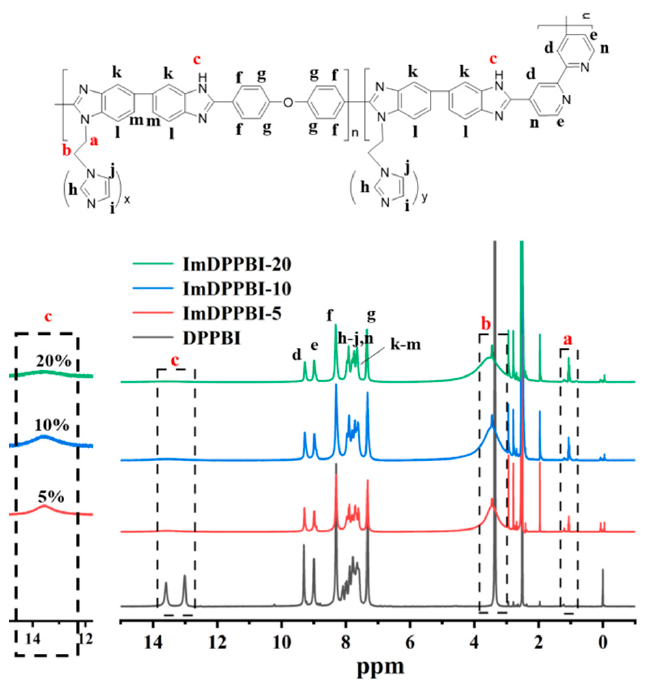
Figure 2. 1 H NMR spectra of the DPPBI and grafted ImDPPBI.